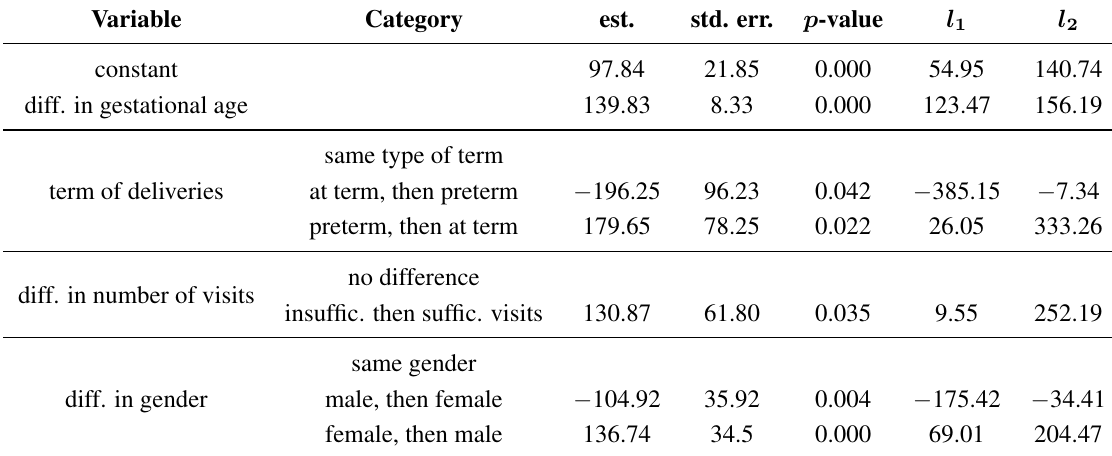
Table 6. Linear regression results for the differences in birthweight: statistically significant covariates ( α = 0.05; adjusted R 2 =